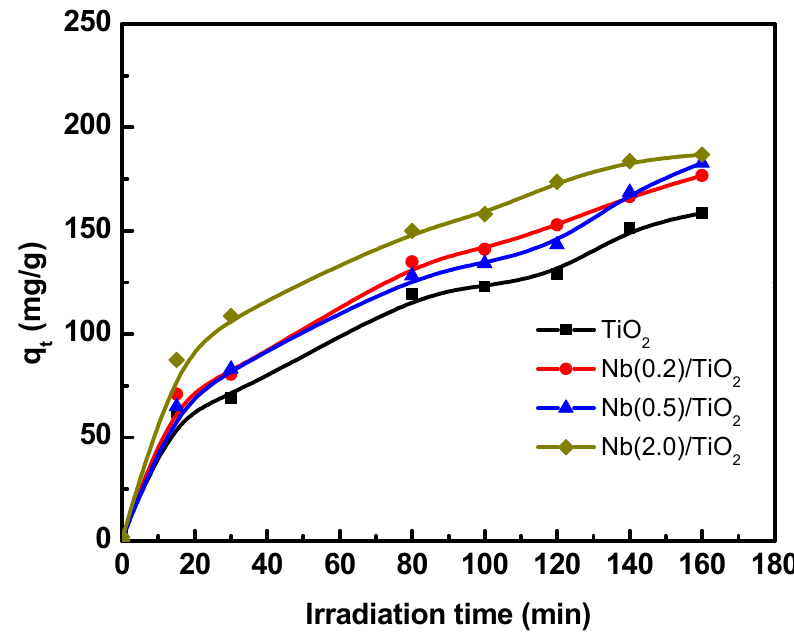
Figure 10. Effect of the contact time on the adsorption capacity of phenol red concentration as a function of irradiation time for TiO 2 , TiO 2 /0.2Nb, TiO 2 /0.5Nb, and TiO 2 /2.0Nb.